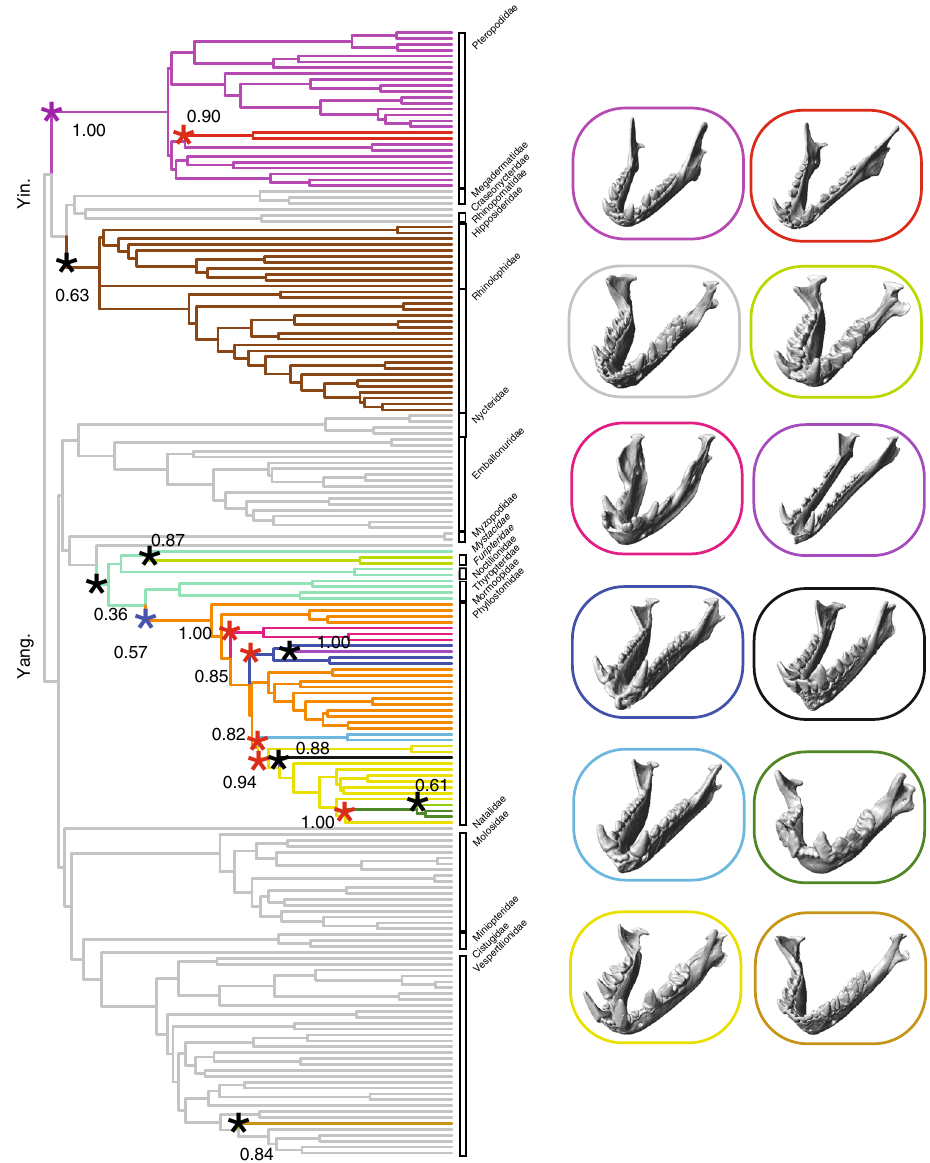
Fig. 5 Evolutionary shifts (asterisks) in mandible shape across bats. Shifts were determined by l1ou adaptive landscape model fi tting on pPCA scores using pBIC (pPC 1 – 4; Fig. 1). Bootstrap support is given for shift locations. Blue shifts = transition in echolocation type, Red shifts = transitions in diet, Purple shifts = transition in echolocation type and diet, Black shifts = no transition. Representative taxa from well-supported shifts, from top to bottom; Left: Rousettus aegyptiacus, Myotis lucifugus, Desmodus rotundus, Anoura geoffroyi, Lonchophylla robusta, Chiroderma villosum ; Right: Syconycteris australis, Noctilio leporinus, Choeronycteris mexicana, Rhinophylla pumilio, Sphaeronycteris toxophyllum, Tylonycteris robustula . Yin. = Yinpterochiroptera. Yang. =